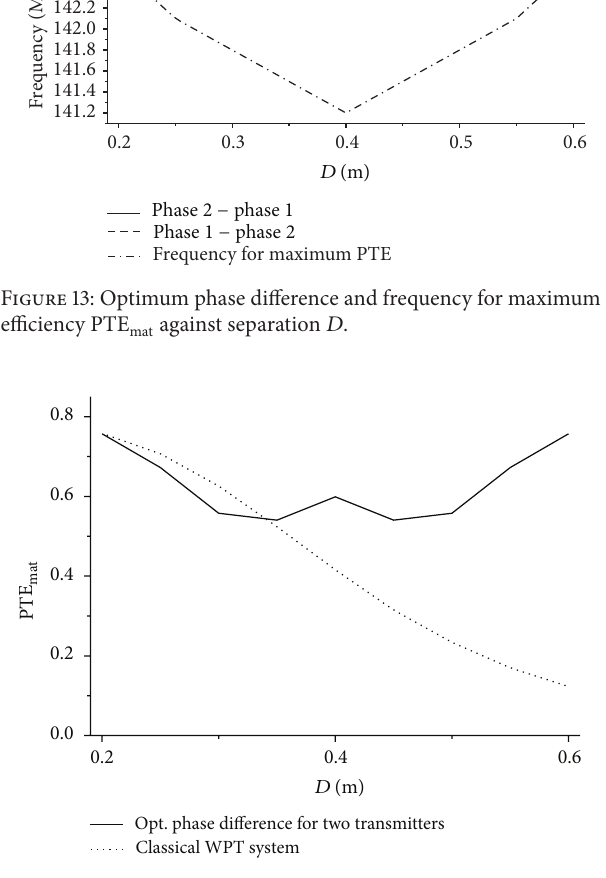
Figure 14: Efficiency of the considered WPT systems. Two different systems are considered: a WPT system with two transmitters and phase difference optimized for each separation 𝐷 (solid line); the classical WPT system shown in Figure 5(b) (dotted